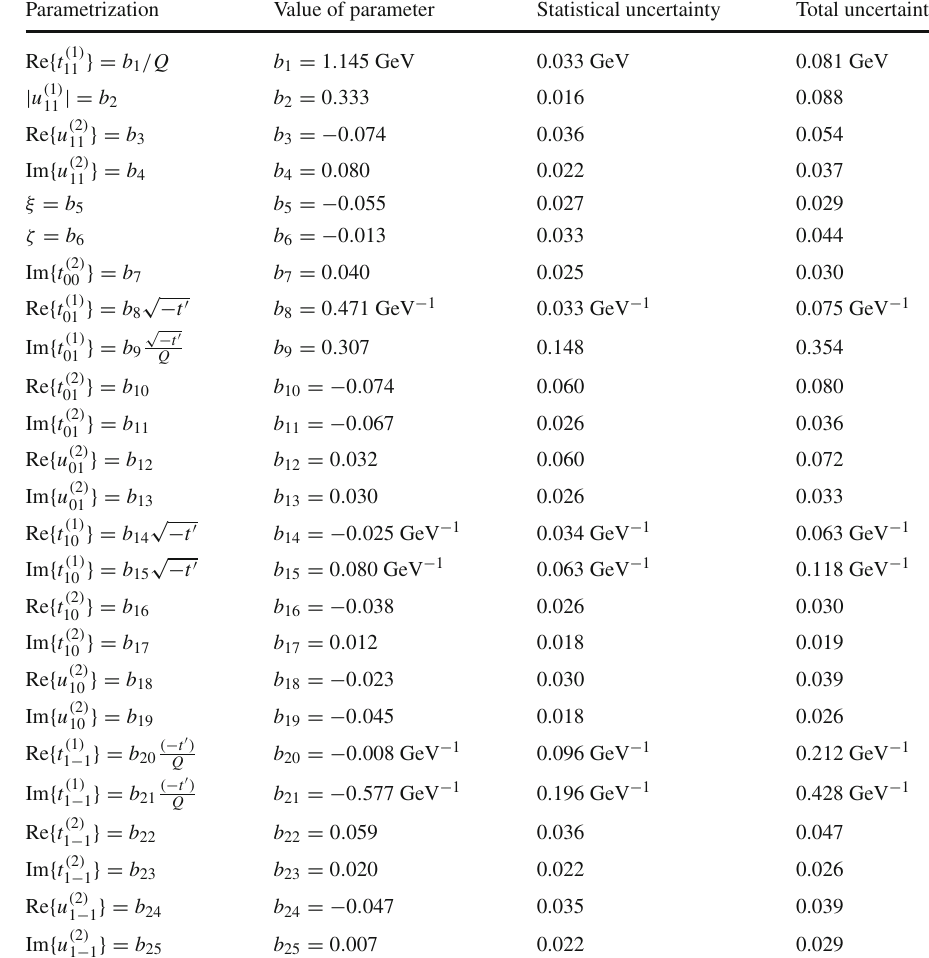
Table 2 Parametrization of the Parametrization Value of parameter Statistical uncertainty Total helicity-amplitude ratios and parameter values extracted from the fit. The combinations of the helicity-amplitude ratios ξ and ζ are defined in Eq. (58). An additional scale uncertainty of 8% originating from the uncertainty on the target polarization is present for the ( 2 ) ( 2 ) ξ and ζ , but ratios t λ V λ γ , u λ V λ γ , not shown. An extra scale uncertainty of 2% originating from the uncertainty on the beam polarization is present for